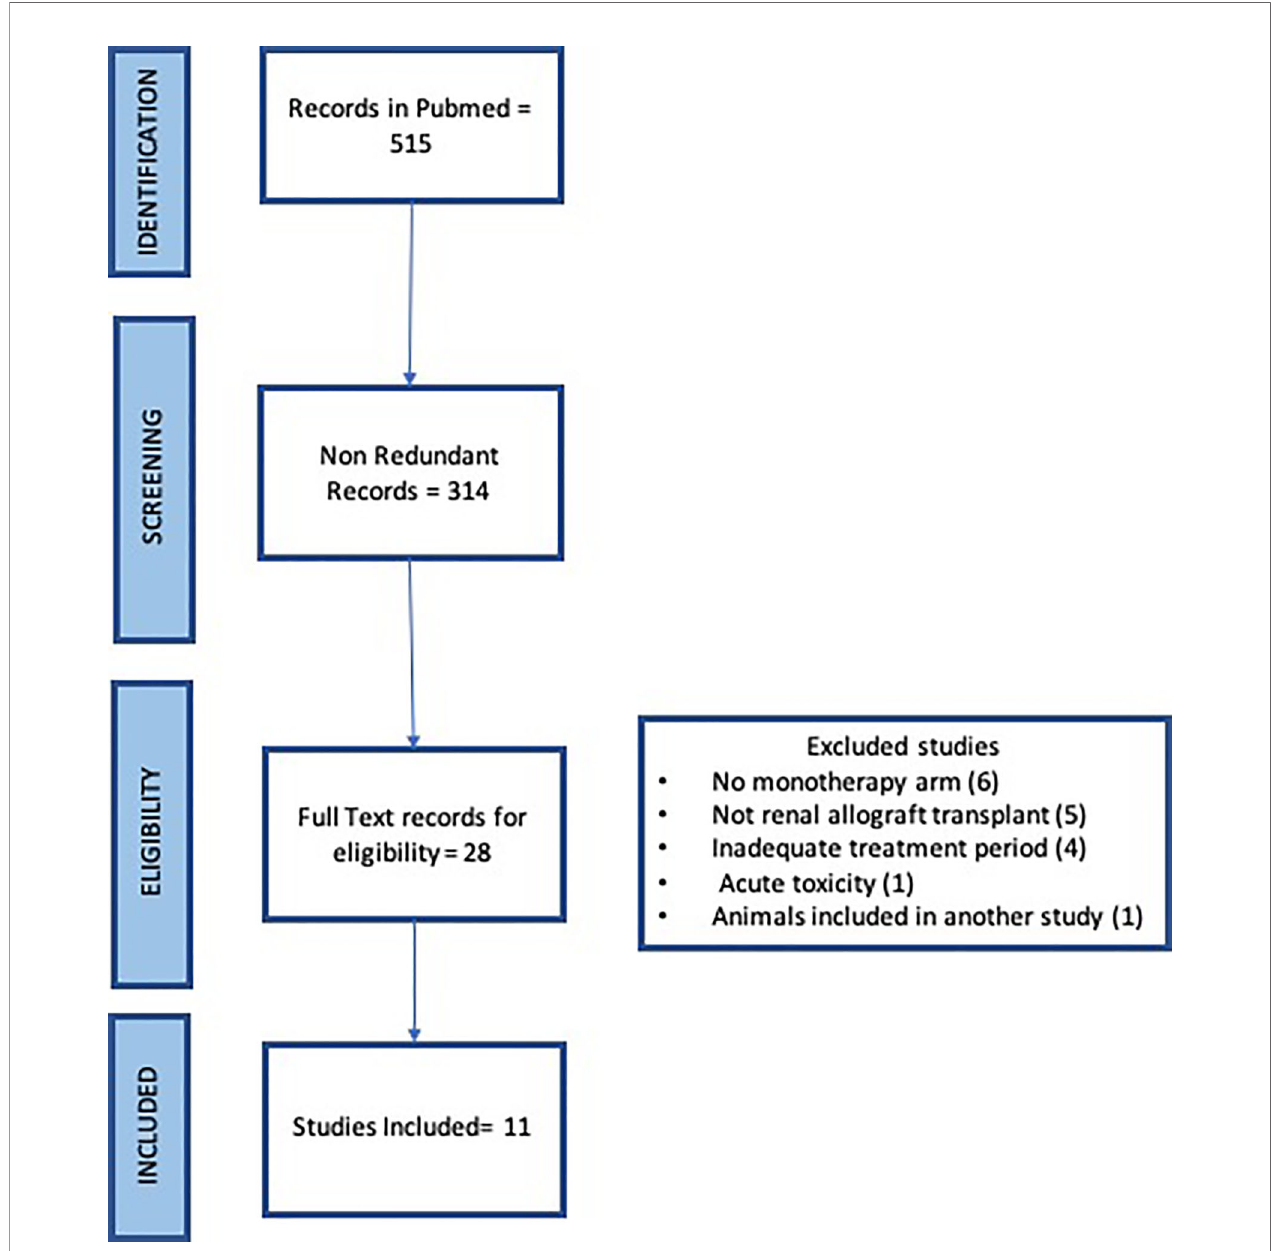
FIGURE 1 | PRISMA Flow Chart of Literature